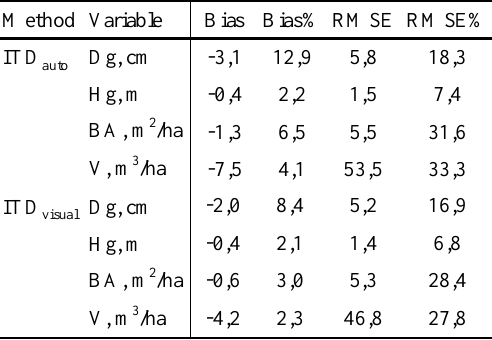
Table 5. Accuracy of the ITD-methods in young and mature